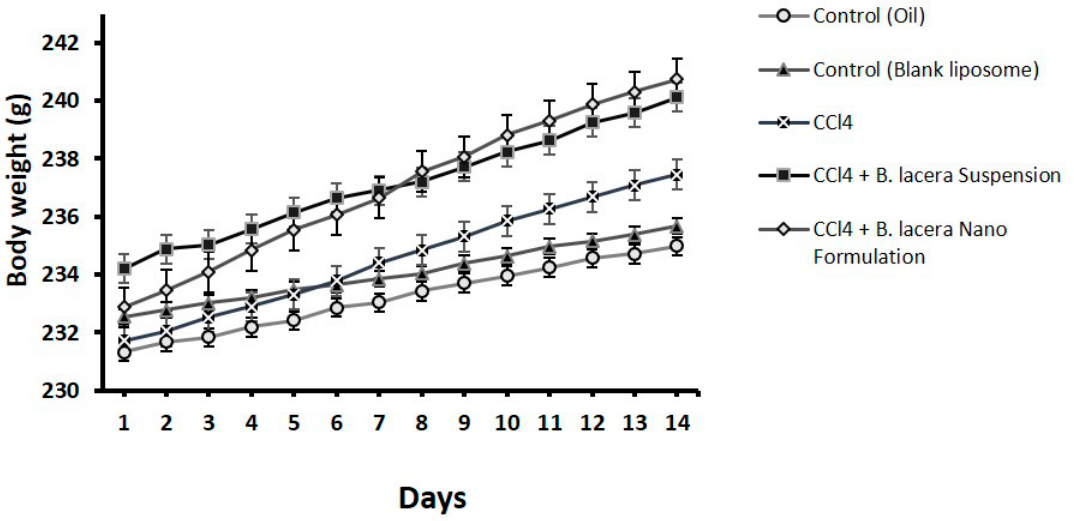
Figure 3. Effect of B. lacera leaf extract and its liposomal preparation on body weight of CCl 4 treated rat for14 days. Data are presented as mean ± standard error of mean, where n = 6.